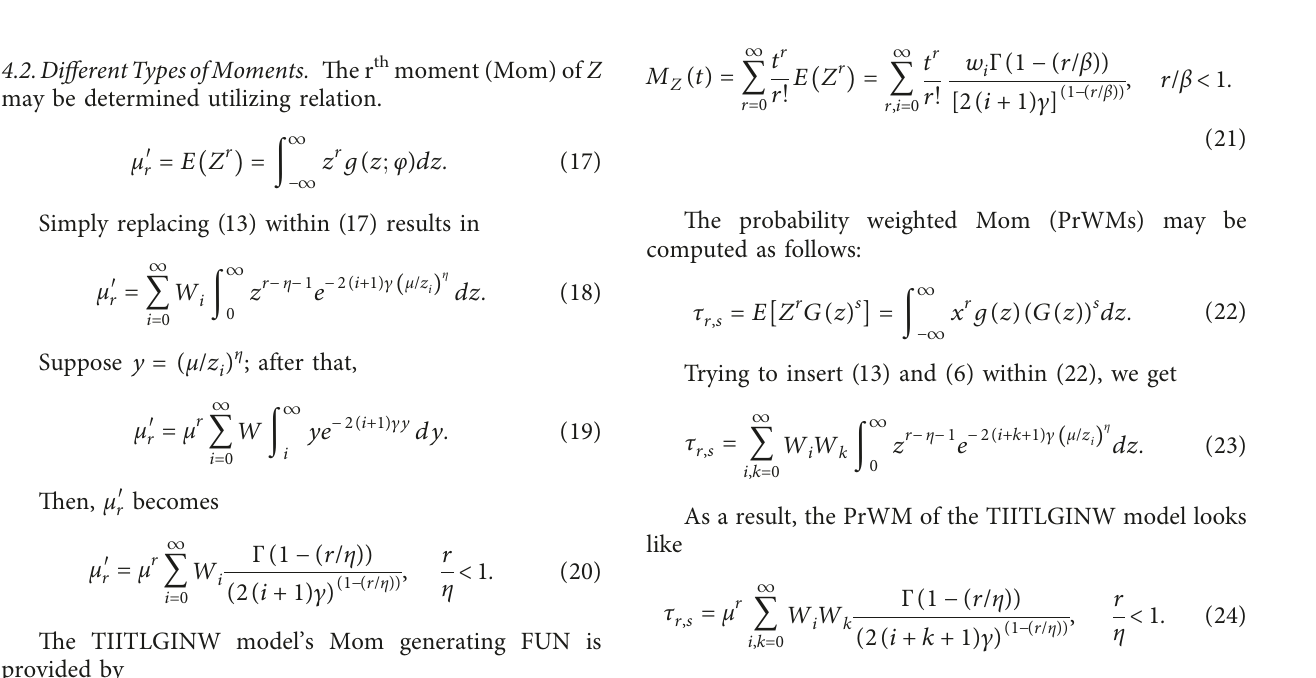
Figure 2: TIITLGINW hrf graphs for appropriate parameter